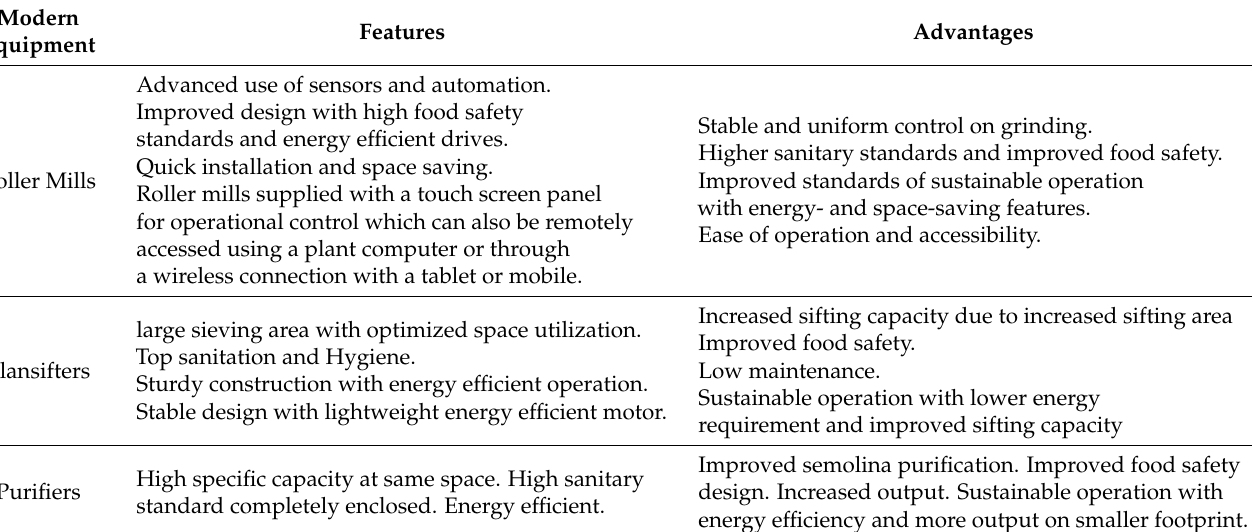
Table 7. Advances in three principal pieces of milling equipment used in a durum milling